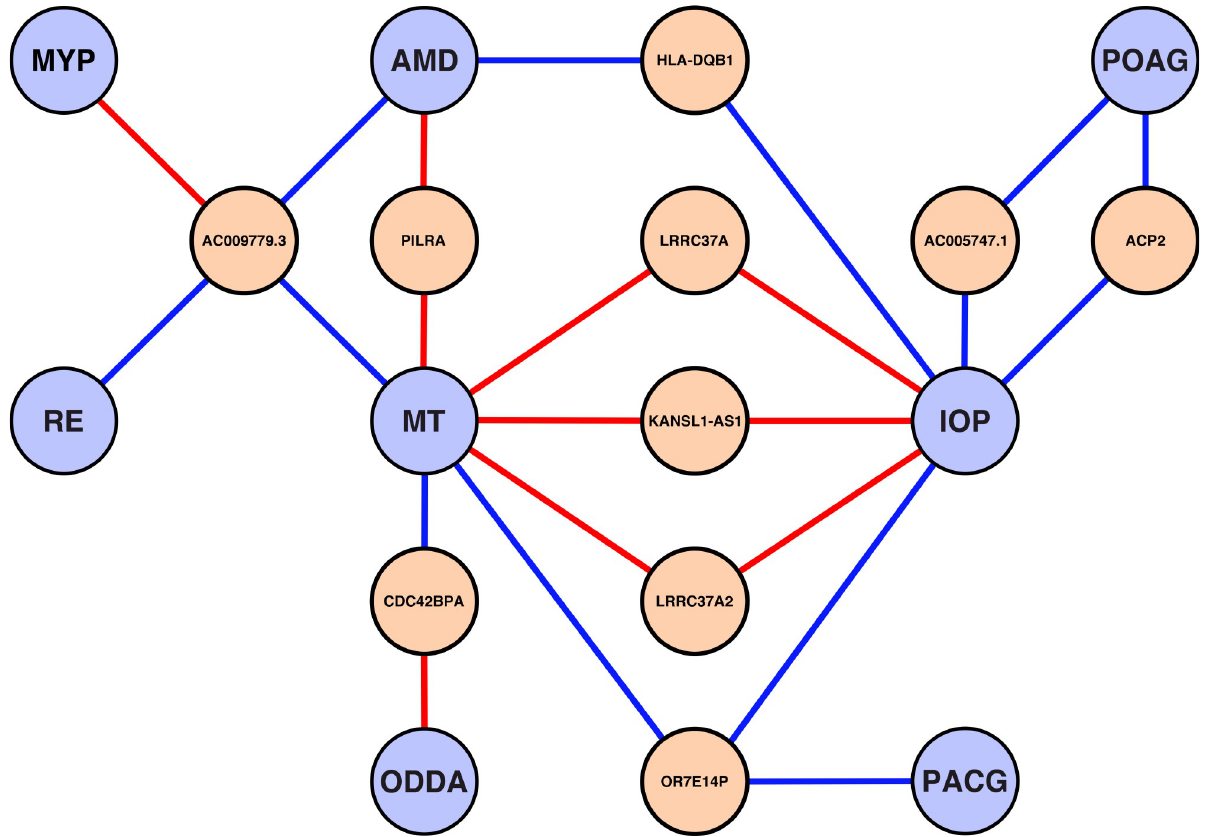
Fig 4. eGenes regulated by multiple complex eye disease- or trait-associated variants. Ten eGenes (orange) were regulated by genome-wide significant GWAS variants of at least two different complex eye diseases or traits (light blue). Connective lines are colored according to the eQTL effect direction of the risk-/trait- increasing allele. Red lines reflect higher gene expression whereas blue lines represent downregulation of expression. AMD = age-related macular degeneration; IOP = intraocular pressure; MT = macular thickness; MYP = myopia; ODDA = optic disc—disc area; PACG = primary angle closure glaucoma; POAG = primary open-angled glaucoma; RE = refractive error.